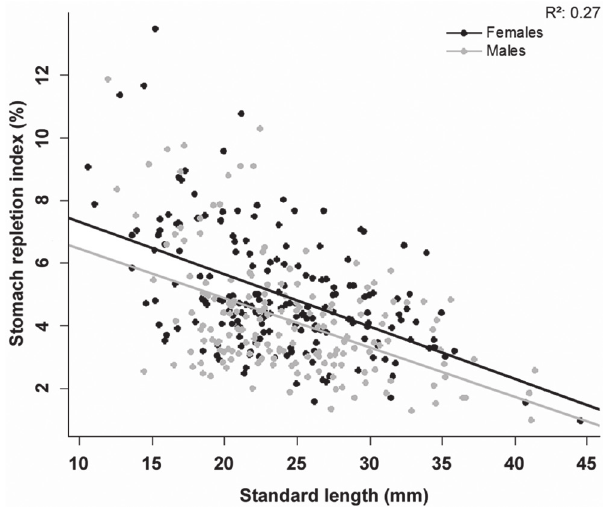
Fig. 3. Index of stomach fullness in relation to standard length. Ontogenetic